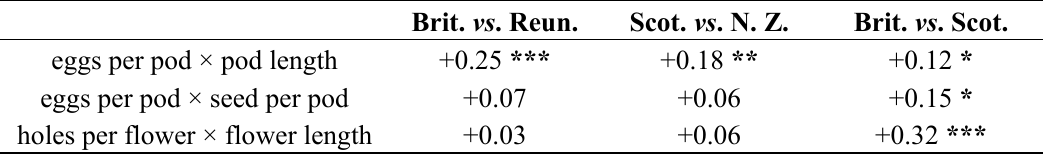
Table 3. Spearman’s rank order correlation coefficients between egg laying (or consumption) and Ulex europaeus ’ pod (or flower)